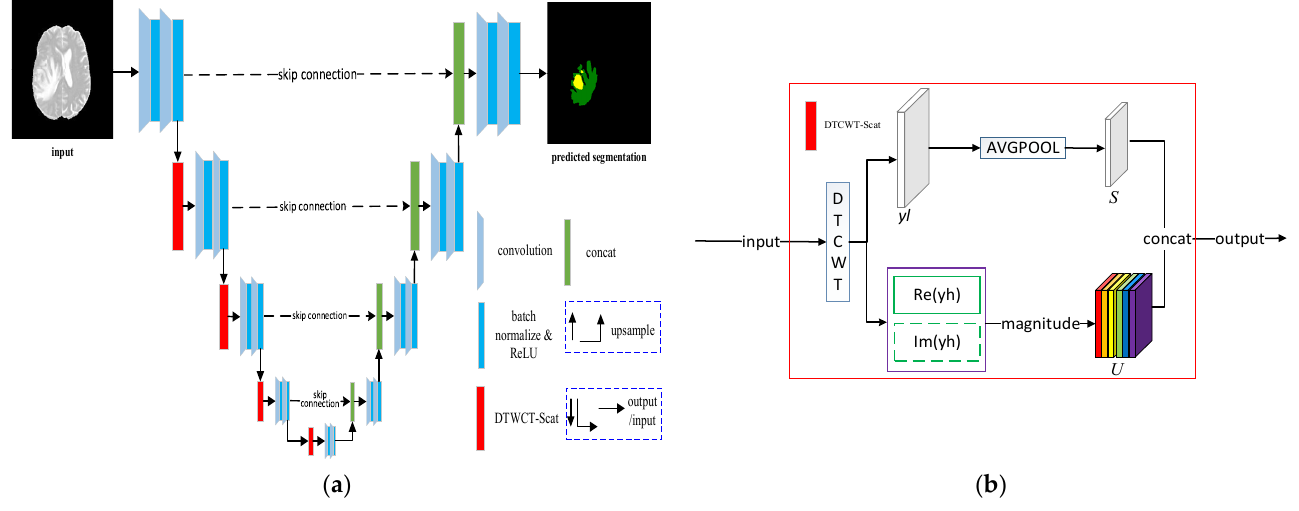
Figure 4. LSW-Net model. ( a ) LSW-Net; ( b ) DTCWT-Scat module.